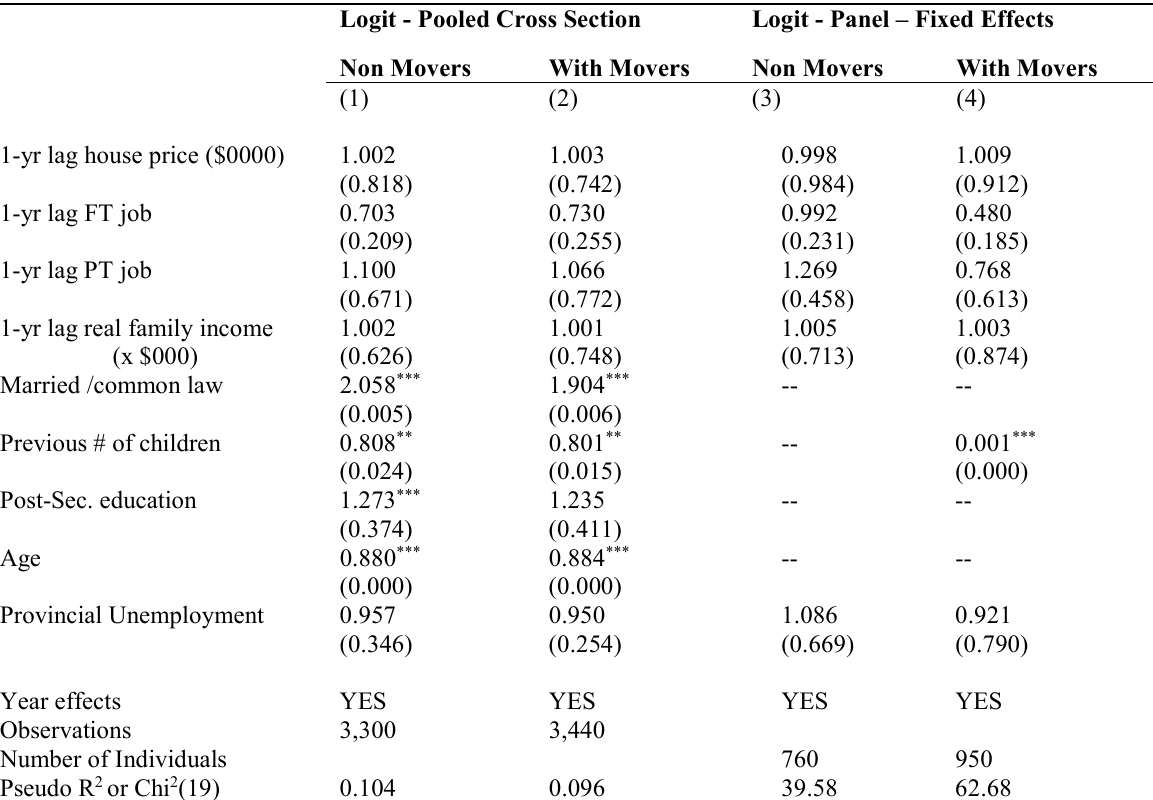
Table 3: Effect of house prices on marginal fertility of renters (proportional effect on Odds Ratios, p-values in